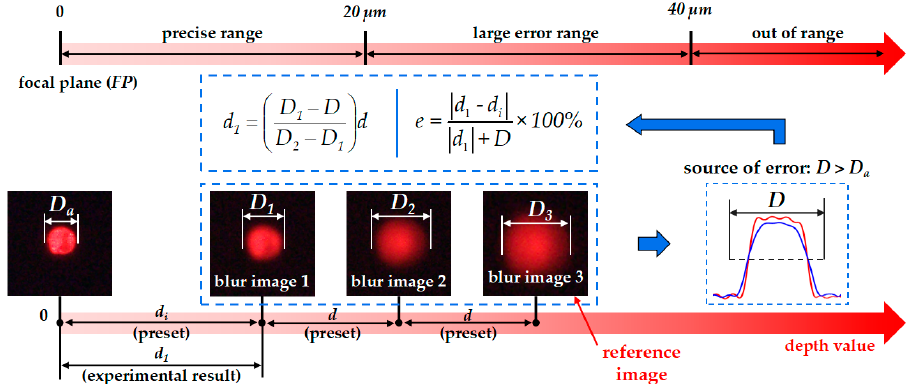
Figure 11. Schematic of multiple depth from defocus (MDFD) experiment.